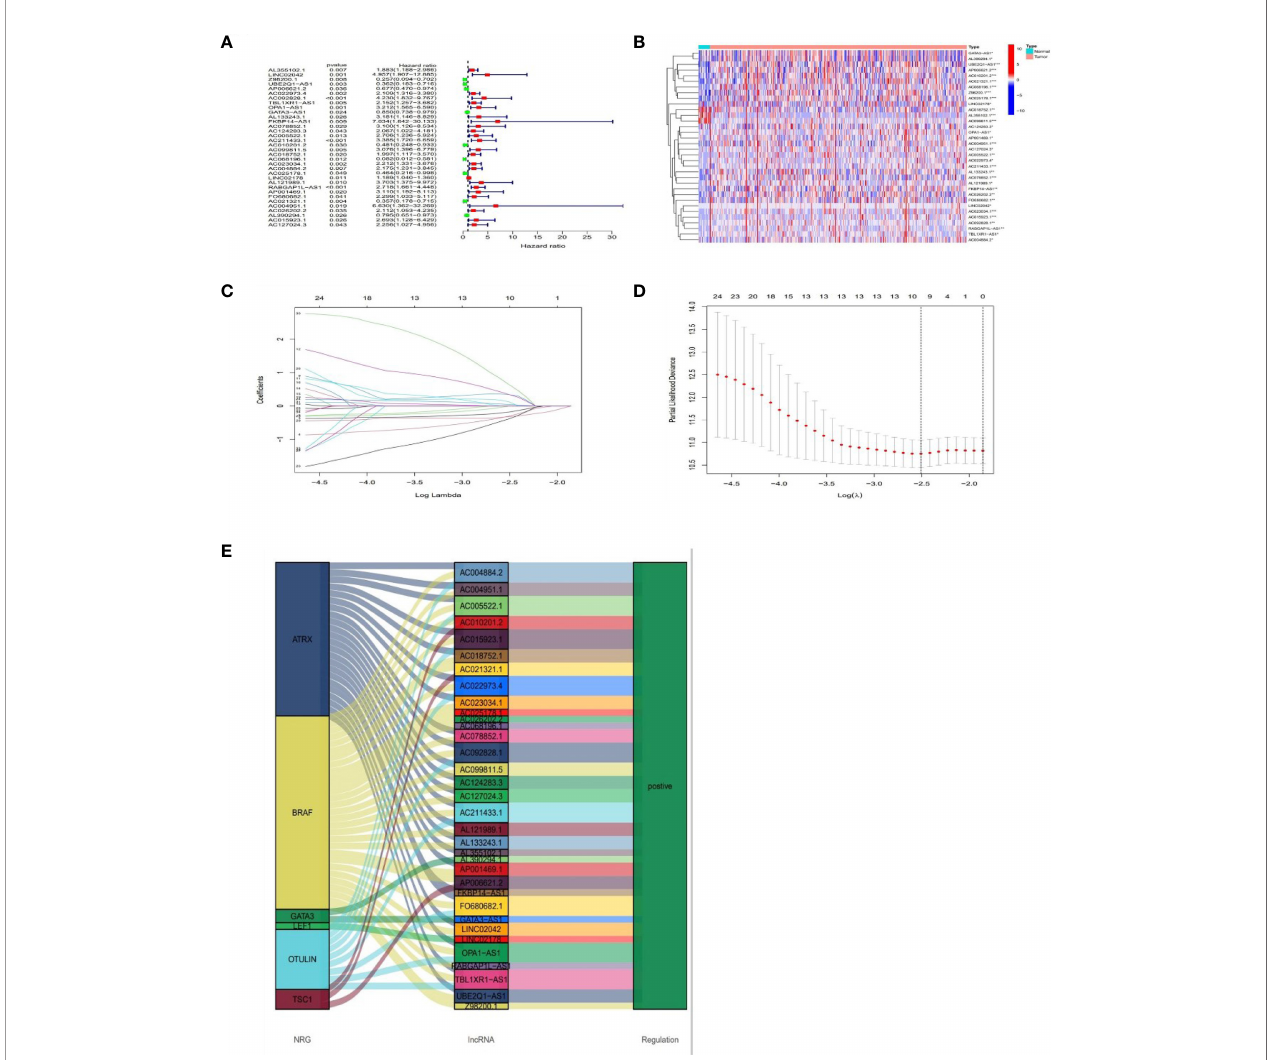
FIGURE 3 | Prognosis of lncRNAs associated with necroptosis in BLCA. The forest plot shows prognostic lncRNAs using univariate Cox regression analysis (red:HR>1 green:HR<1) (A) . The heat map of 34 prognostic lncRNAs (B) . The 10-fold cross-validation for varying selection in the LASSO regression (C) . The pro fi le of the LASSO coef fi cient of 7 necroptosis-associated lncRNAs (D) . The necroptosis genes and 34 related lncRNAs Sankey graph (E) . (*: p < 0.05, **: p < 0.01, and ***: p <